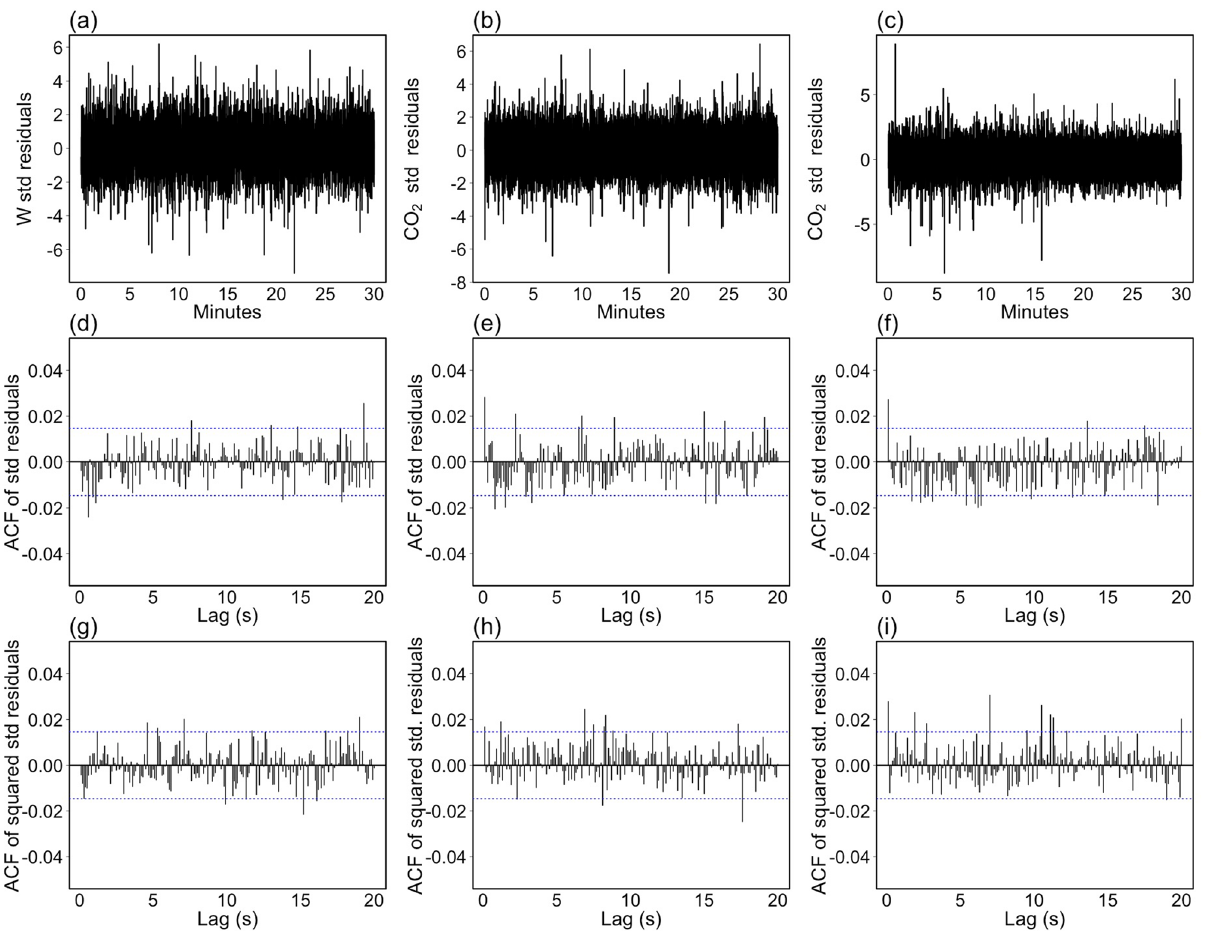
Figure 4. Diagnostic check of ARIMA-CGARCH models estimated on high-frequency time series depicted in Fig. 2. ( a – c ) The standardized residuals. ( d – f ) The corresponding autocorrelation function (ACF). ( g – i ) The ACFs estimated on squared standardized residuals. Dashed blue lines indicate the 95% CI.